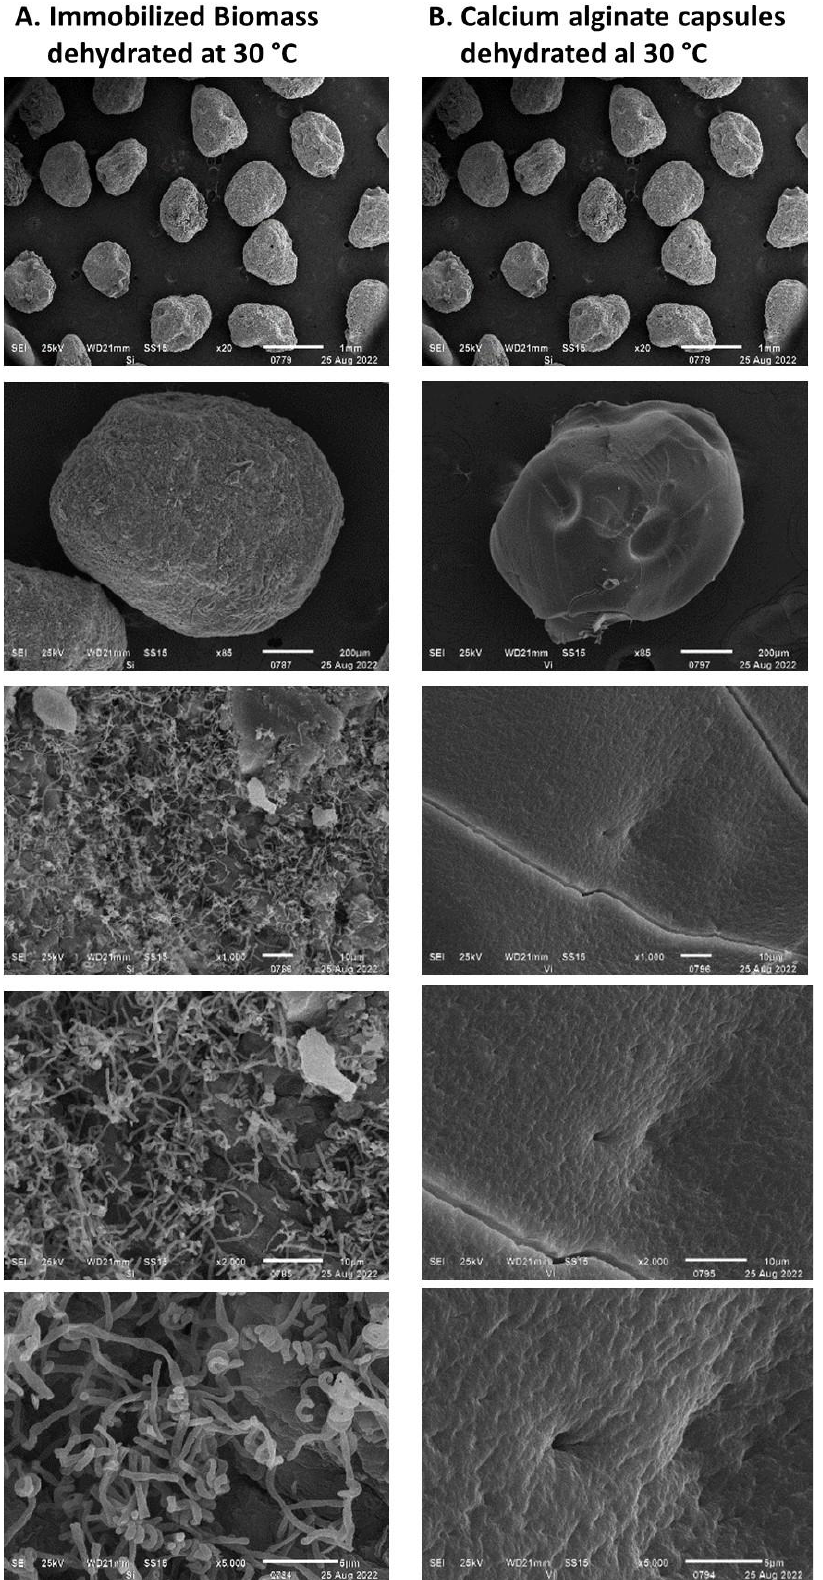
Figure 13. Calcium alginate capsules with ( A ) and without ( B ) biomass dehydrated with heat at 30 ◦ °C.